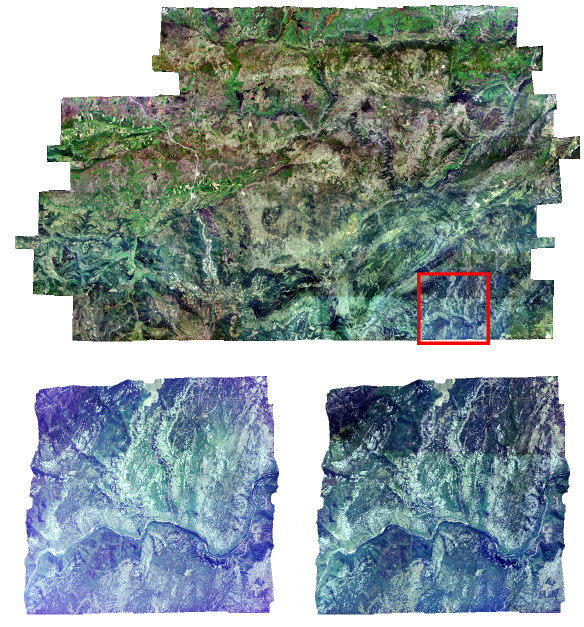
Figure 14. An image and its corresponding image extracted from the orthophotomosaic.